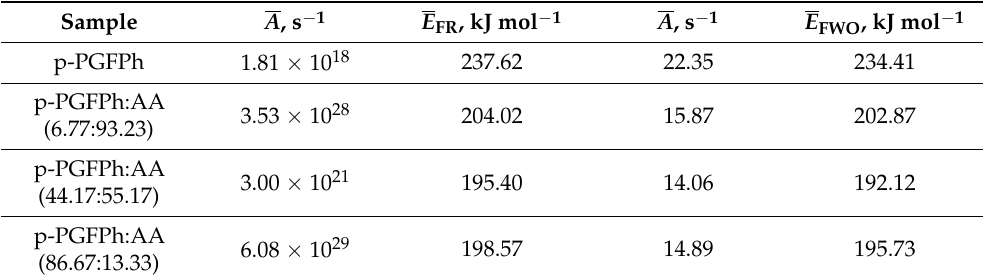
Table 2. p-PGFPh:AA copolymers energy activation values at different ratios in a hydrogen